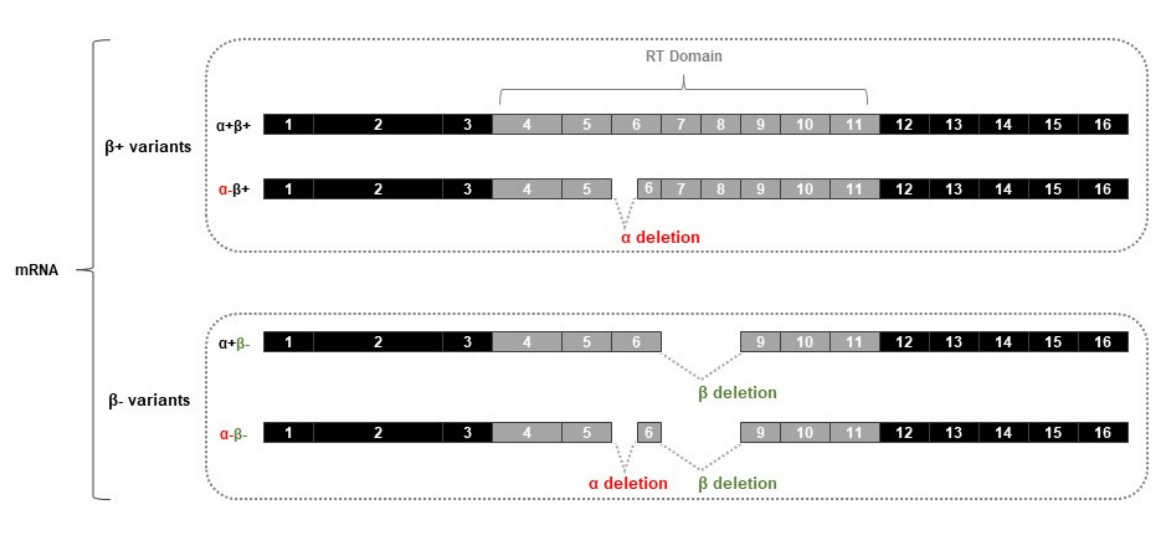
Figure 2. Schematic representation of the main hTERT post-transcriptional events. The two main alternative splicing sites in hTERT RT domain are the α splice site in exon 6, which produces a 36 bp in-frame deletion; and the β splice site in exons 7 and 8, which results in a 182 bp deletion. Four possible combinations of hTERT alternative splicing are possible: α + β +, α − β + (mentioned as β + variants), and α + β − and α − β − (mentioned as β − variants). hTERT: human telomerase reverse